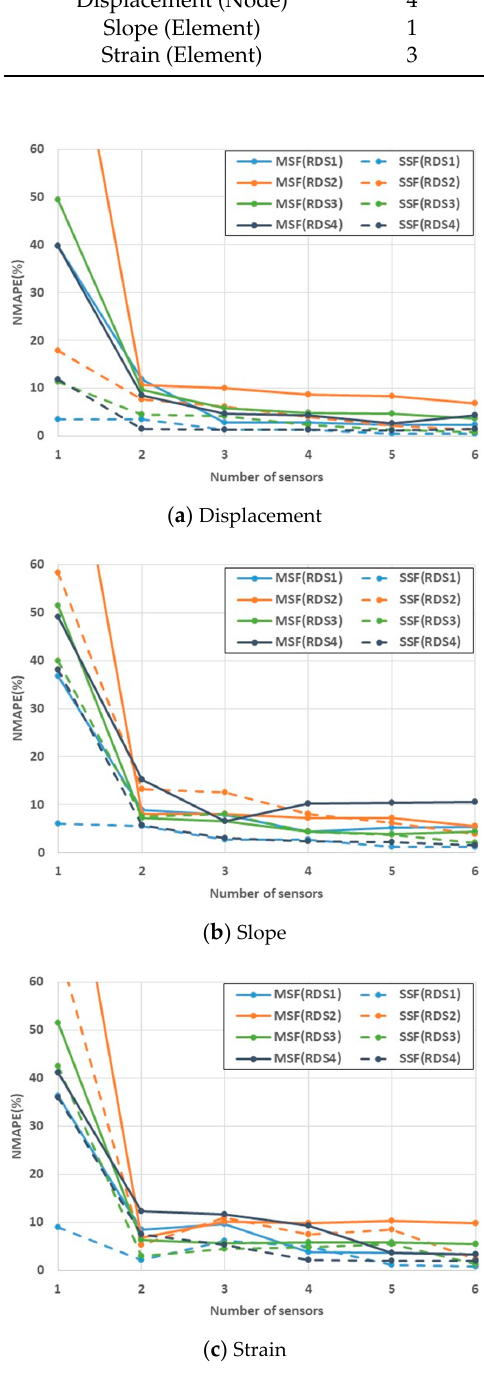
Figure 13. NMAPE by MSF and SSF according to the number of sensors: ( a ) displacement, ( b ) slope, ( c ) strain.